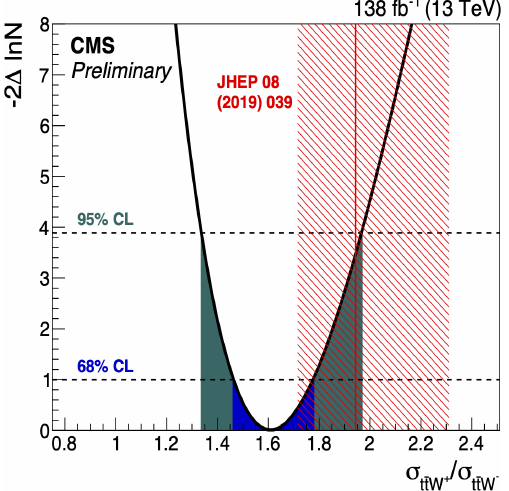
Figure 14. Negative log − likelihood scan for values of the ratio of t¯tW + and t¯tW − cross-sections. The best fit value is found at the minimum of the curve, while the dashed horizontal lines represent the CL limits [41]. The red line and hatched band represent the central value and total uncertainty of the theory prediction without the FxFx merging in Ref.